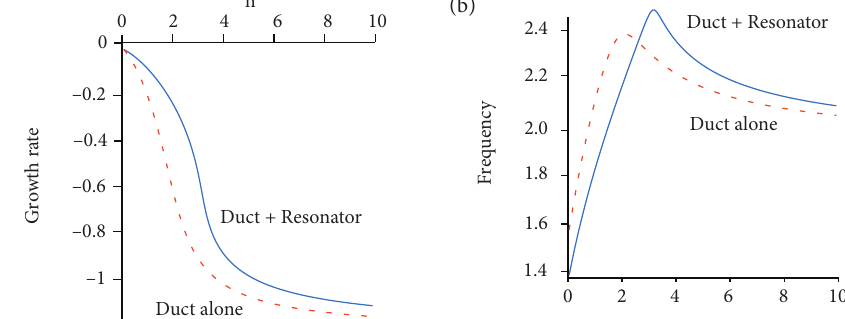
Figure 9. Nominal thermoacoustic characteristics of a ducted resonator (1L mode, τ = 0.6, x